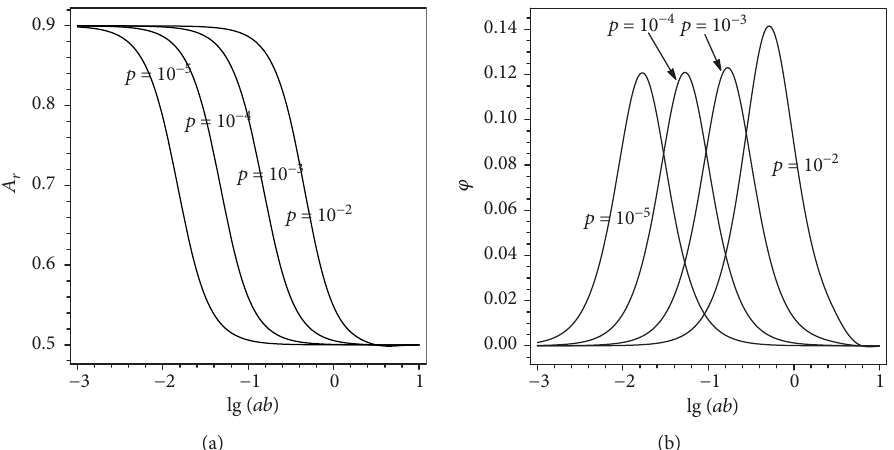
Figure 8: Changes of (a) amplitude ratio A of p ( p = K ′ / K ). The loading coe ffi cients L 1